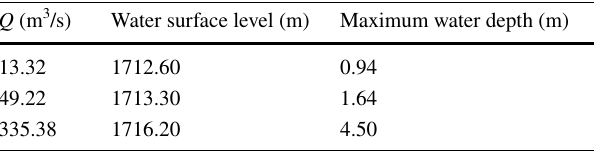
Table 1 Hydraulic parameters at the Shahmokhtar station (Yasuj regional water company, Ministry of Energy)